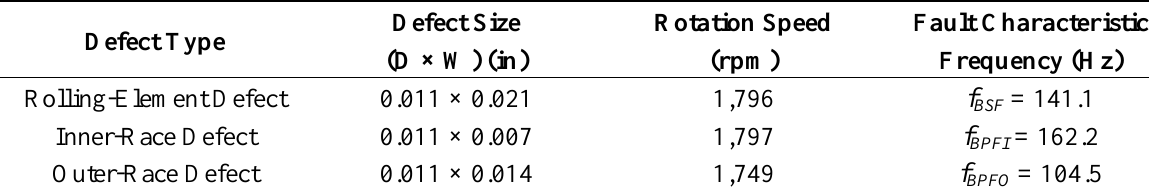
Table 3. Parameters of tested